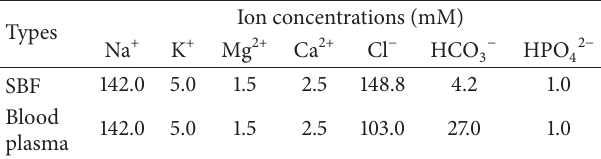
Table 2: Ion concentration of SBF solution in comparison with human blood plasma [18].